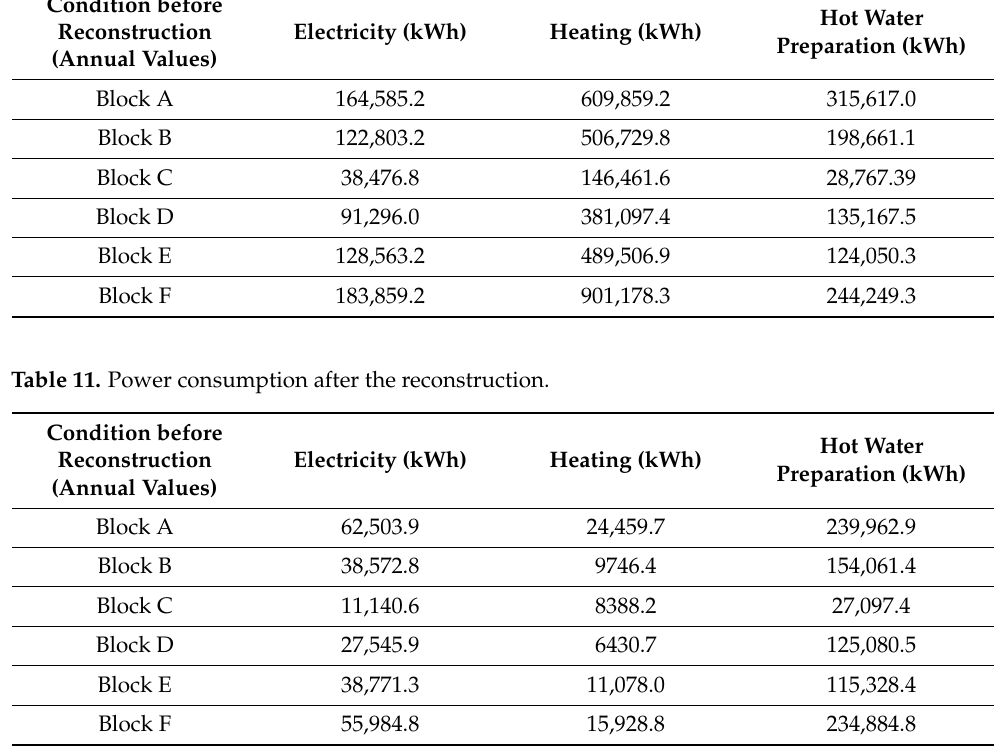
Table 12. Values of conversion factors.